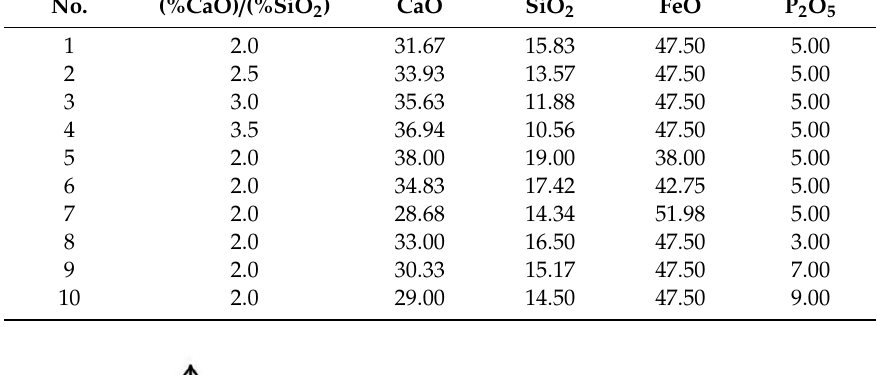
Figure 1. Position of the slag composition in the liquidus diagram of the CaO-FeO-SiO 2 ternary system at 1400 °C and 1500 °C.